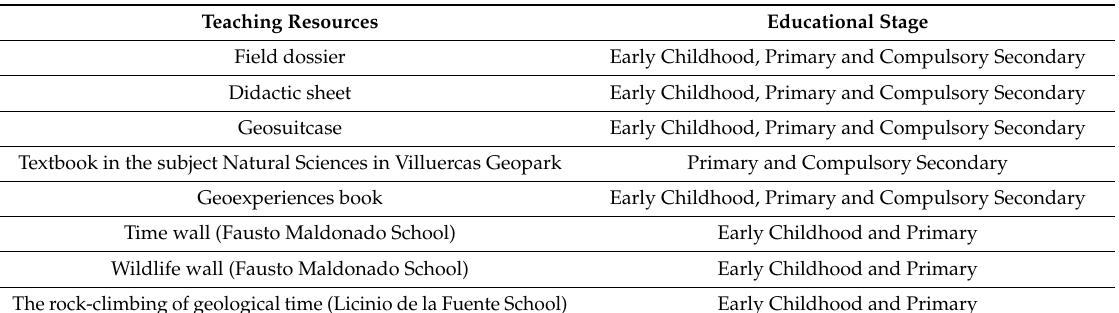
Table 3. Teaching materials created by the Villuercas-Ibores-Jara Geopark. Source: UNESCO